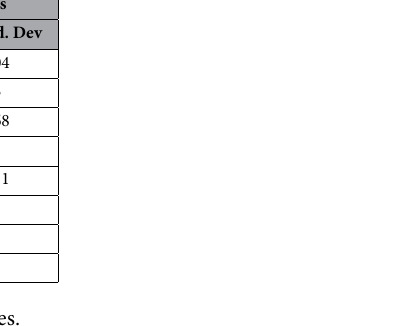
Table 2. Fixed effects and random effects of accuracy